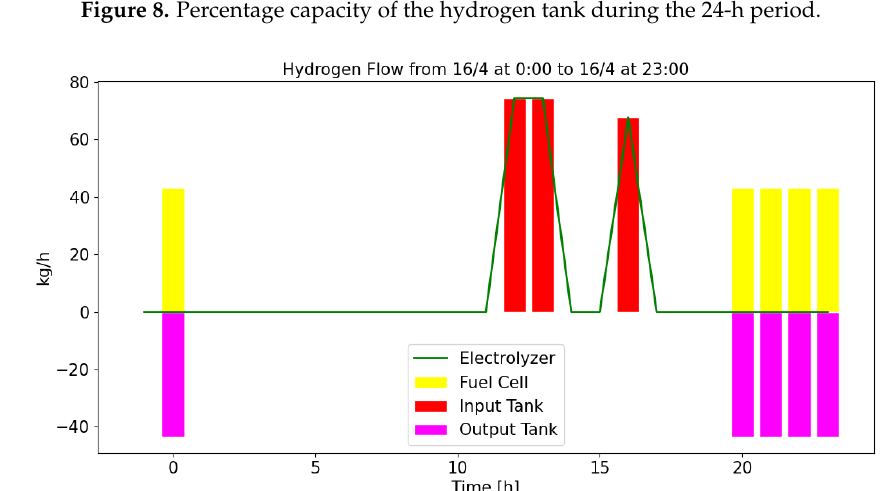
Figure 9. Flow of hydrogen in the